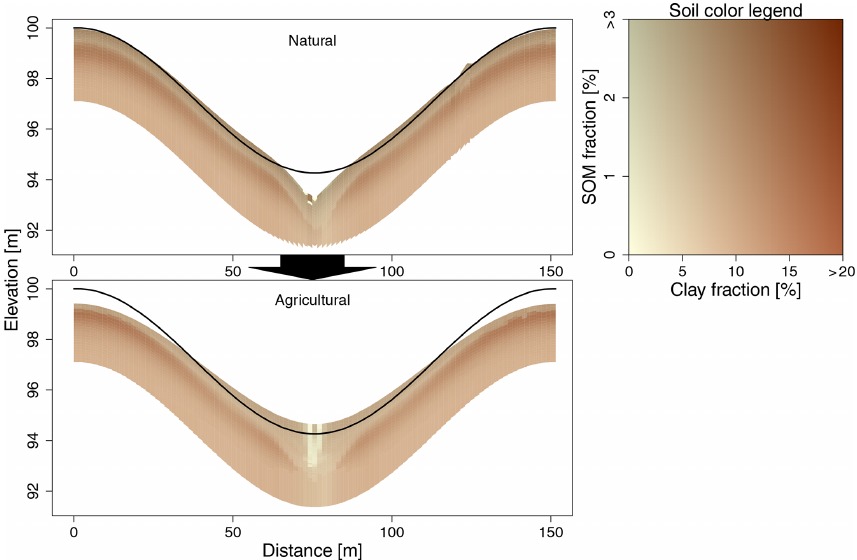
Figure 2. Transect through the catchment at the end of the natural phase and the end of the agricultural phase for the humid scenario ( P = 600mm). The black line indicates initial topography. See Fig. 1 for the location of the